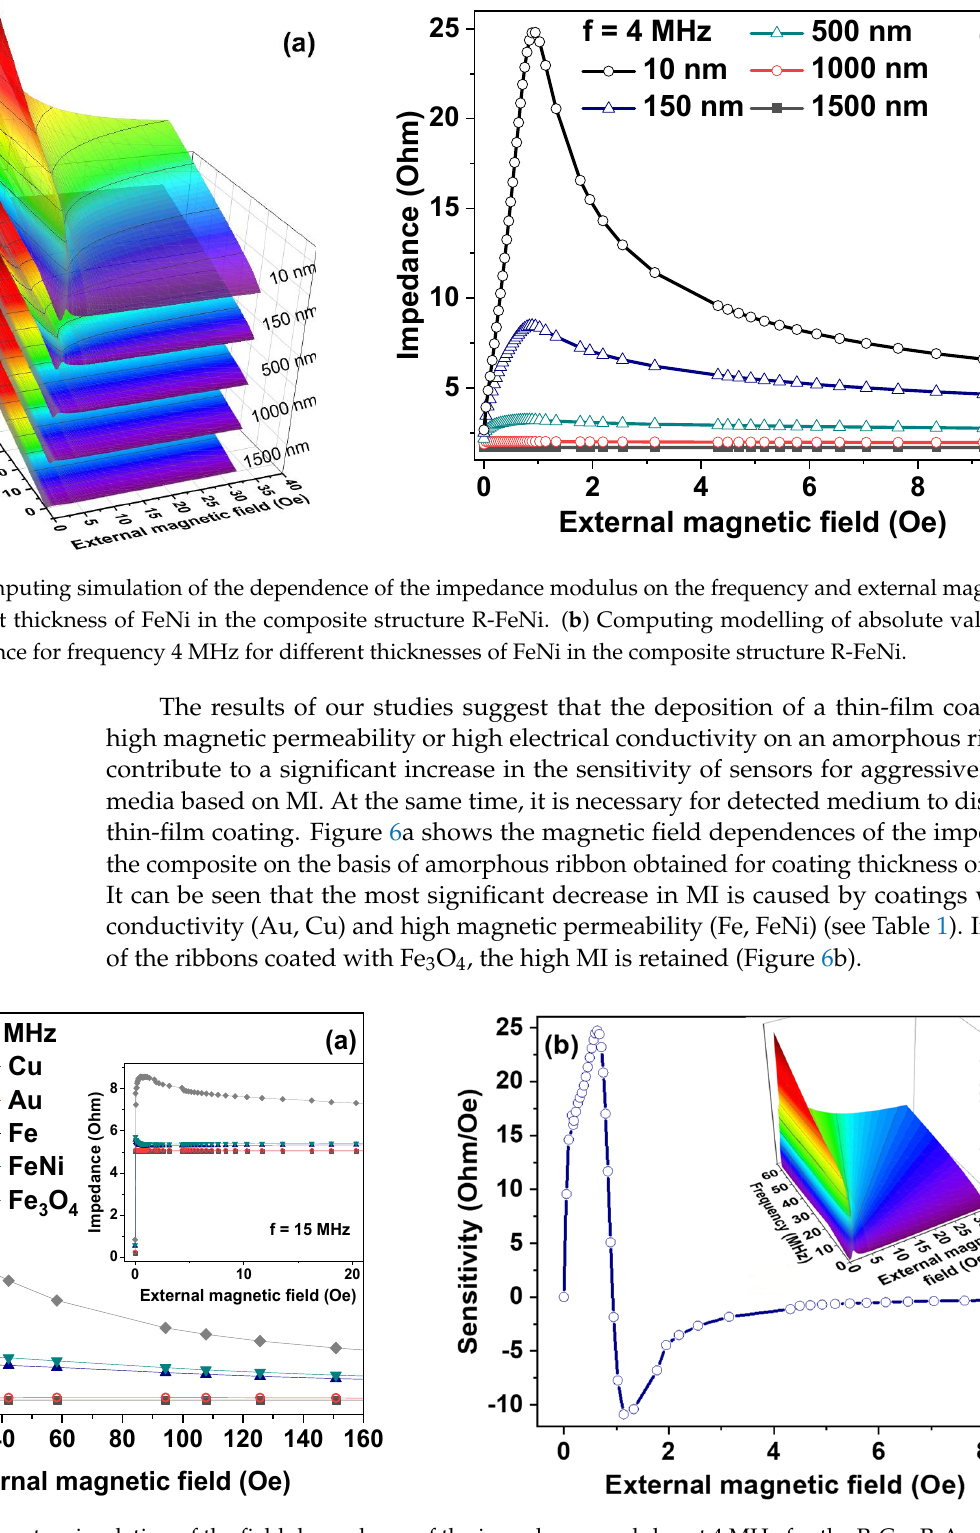
Figure 6. ( a ) Computer simulation of the field dependence of the impedance modulus at 4 MHz for the R-Cu, R-Au, R-Fe, R-FeNi and R-FeO samples (see Table 1) with the same covering thickness of the upper and lower layers of 1000 nm. The inset shows data for excitation current frequency f = 15 MHz. ( b ) Computer simulation of maximum sensitivity for structure R-FeO with thickness of upper and lower layers of 10 nm on 20 MHz. The inset shows dependence of absolute impedance value on frequency and external magnetic field values for this structure.